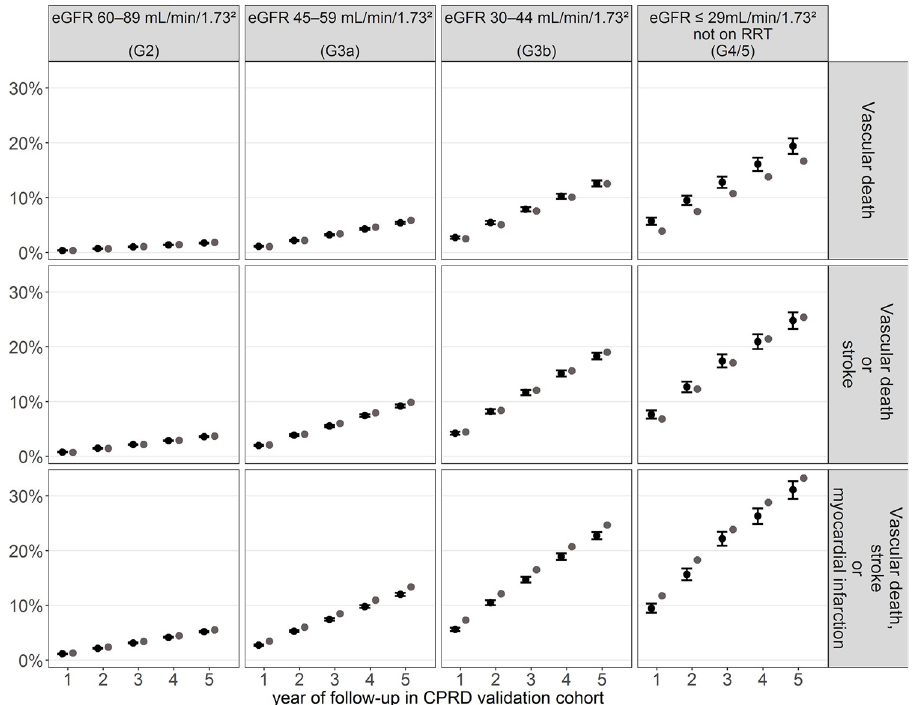
Fig 2. Comparison of cumulative risks predicted by the model and observed Kaplan–Meier risks in the validation cohort for main cardiovascular endpoints and by eGFR category at cohort entry. CI, confidence interval; CKD, chronic kidney disease; CPRD, Clinical Practice Research Datalink; CVD, cardiovascular disease; eGFR, estimated glomerular filtration rate; RRT, renal replacement therapy.